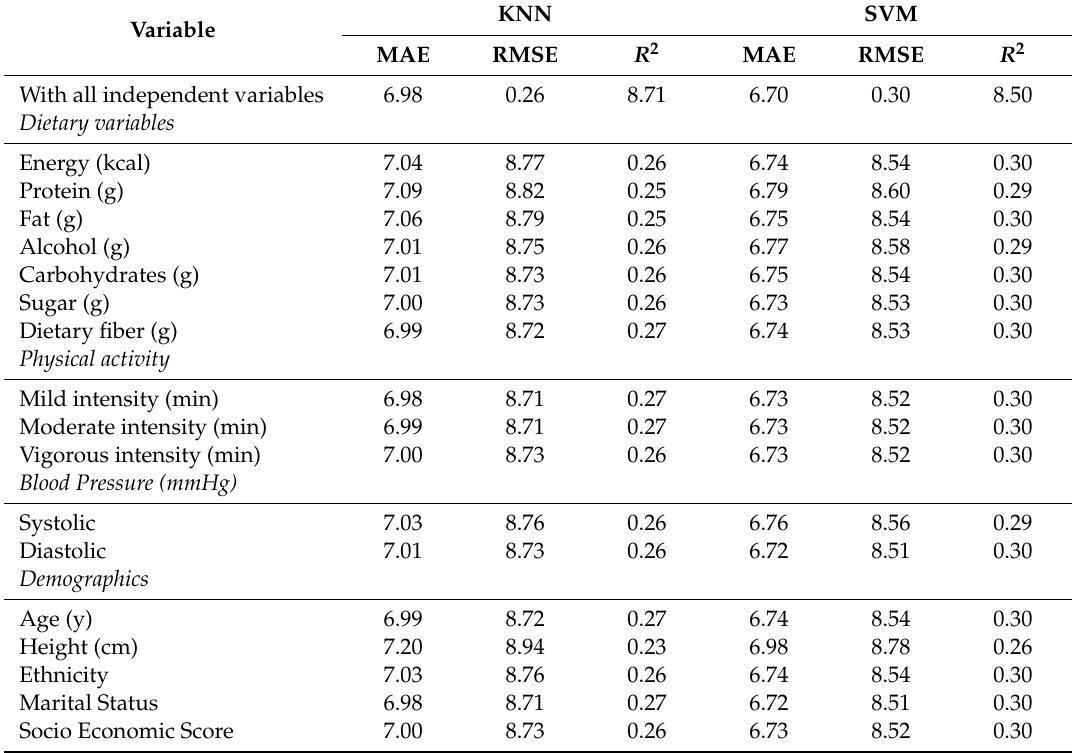
Table 3. Further exploration of the best-fit kNN